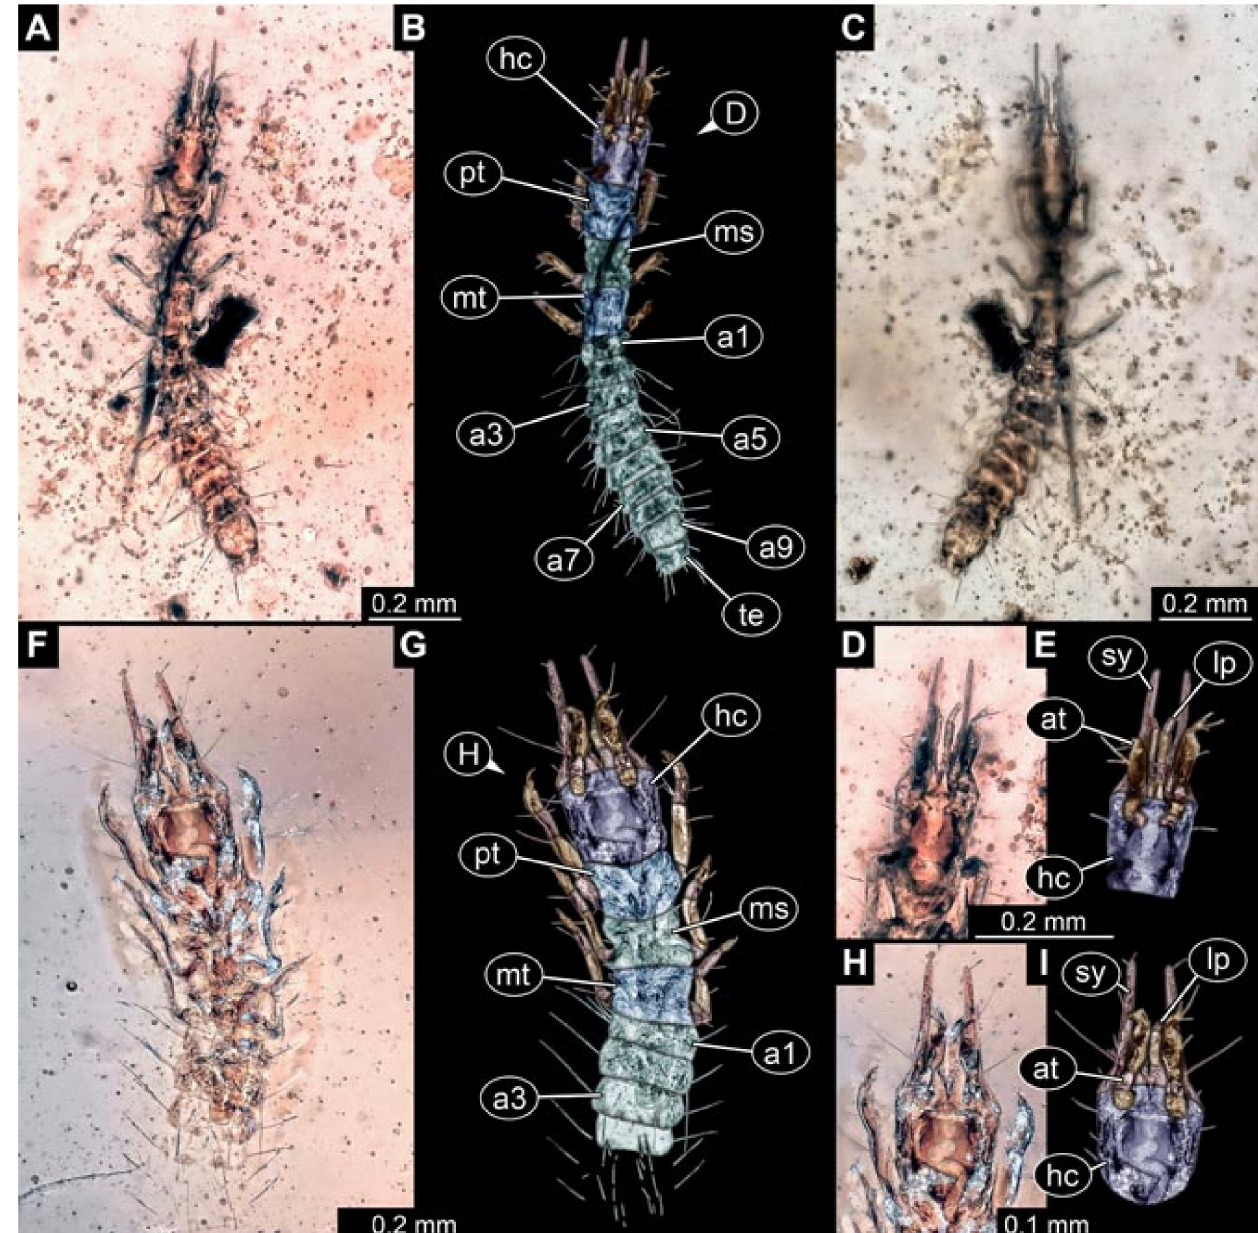
Figure 17. Specimens in Myanmar amber. ( A – E ) Specimen 5842 (PED 0900-3). ( A ) Dorsal view. ( B ) Dorsal view, colour- marked. ( C ) Ventral view. ( D ) Close-up of head in dorsal view. ( E ) Close-up of head in dorsal view, colour-marked. ( F – I ) Specimen 5843 (PED 0900-4). ( F ) Dorsal view. ( G ) Dorsal view, colour-marked. ( H ) Close-up of head in dorsal view. ( I ) Close-up of head in dorsal view, colour-marked. Abbreviations: a1–a9 = abdomen segment 1–9; at = antenna; hc = head capsule; lp = labial palp; ms = mesothorax; mt = metathorax; pt = prothorax; sy = stylet; te = trunk